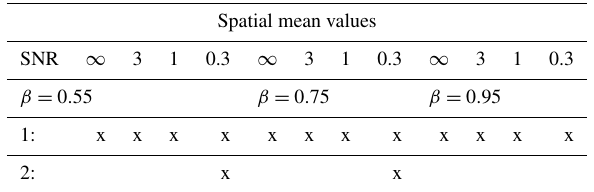
Table 3. Hypothesis testing results for spatial mean reconstructed data compared to Monte Carlo ensembles of fGn and AR(1) pro- cesses. The null hypotheses 1 and 2 are the same as in Table 2, and the “x” has the same